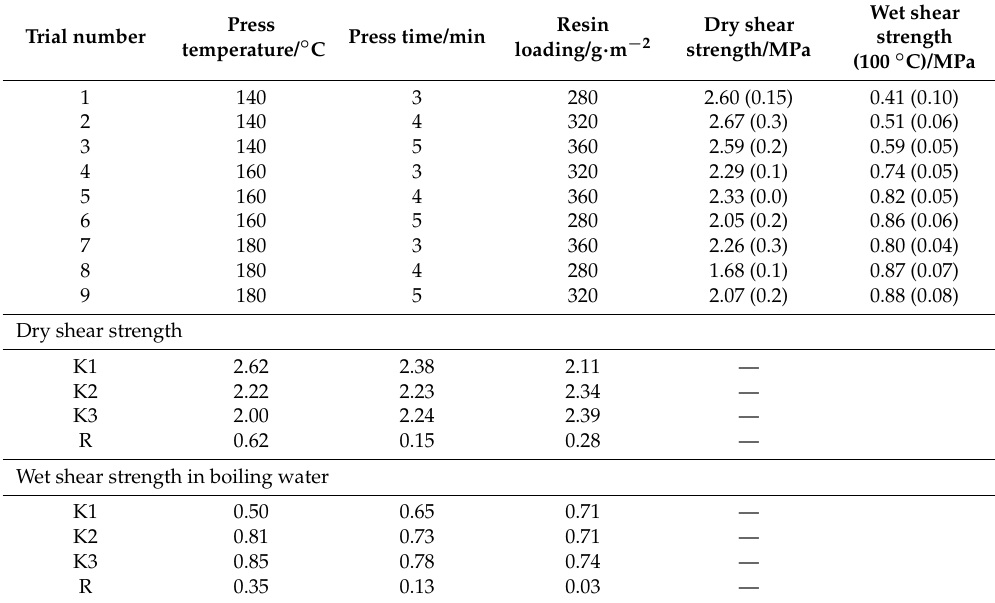
Table 5. Dry and wet strength of soy-based plywood with cross-linker PFG and their range analysis.